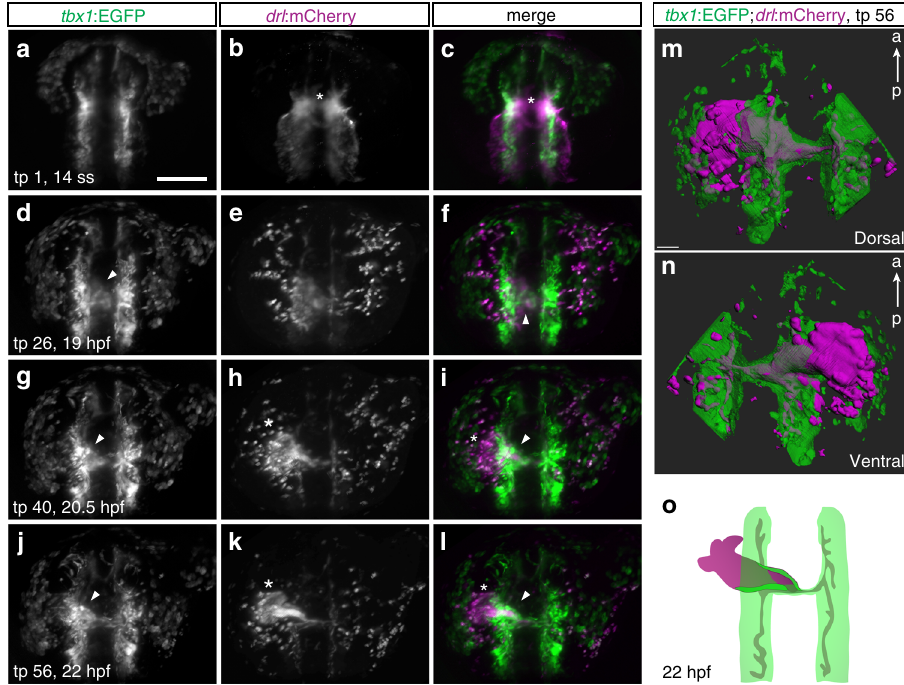
Fig. 3 A tbx1 + sheath forms at the base of the FHF-derived heart tube. a – l Maximum intensity projections of representative stages from SPIM-imaged tbx1: EGFP ; drl:mCherry double-positive transgenic embryos; dorsal views, anterior to the top. Imaging was initiated at 14 ss (16 hpf) and cardiac development followed until linear heart tube (LHT) stage (22 – 23 hpf, n = 3). a – c 14 ss stage embryo at the onset of medial FHF migration (asterisk). d – f The forming cardiac disk already contains tbx1 :EGFP-positive cells (arrowhead). g – l tbx1 :EGFP-positive cells (arrowhead in g , i ) assemble at the base of the extending drl reporter-expressing heart cone (asterisk in h , k ) and are contained in the LHT (arrowhead in j , l ), note the absence of tbx1 :EGFP reporter-expressing cells at the leading edge (asterisk in k , l ) of the forming heart tube. m , n 3D segmentation (dorsal and ventral view) revealing a tbx1 reporter-expressing sheath of cells engul fi ng the drl reporter-expressing endocardium at 22 – 23 hpf. o Schematic of tbx1 and drl reporter-expressing cell arrangements at the end